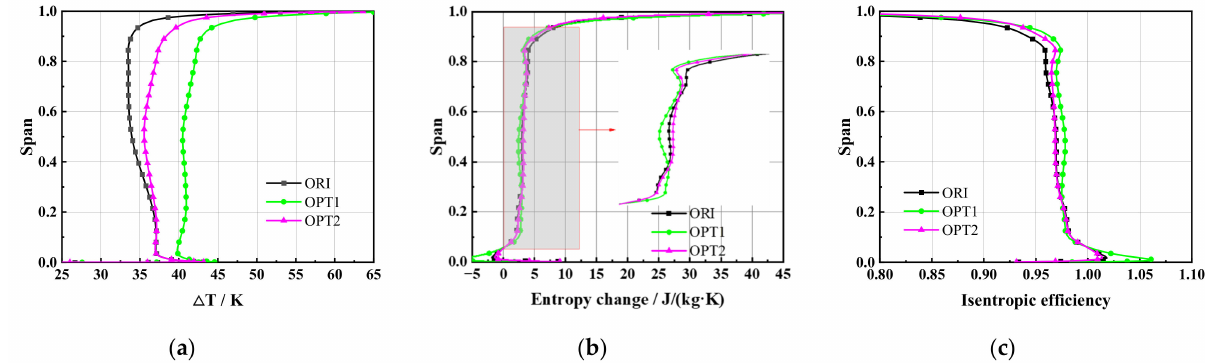
Figure 12. Spanwise distributions of aerodynamic parameters between rotor inlet and outlet: ( a ) total temperature increases; ( b ) entropy change; ( c ) isentropic efficiency.